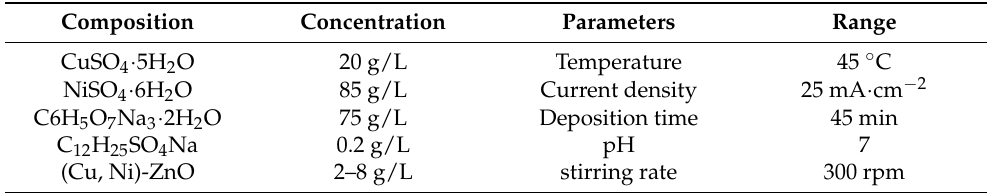
Table 1. The chemical composition and process parameters of electroplating solution for preparing nanocomposite coatings. Composition Concentration Parameters Range CuSO 4 · 5H 2 O 20 g/L